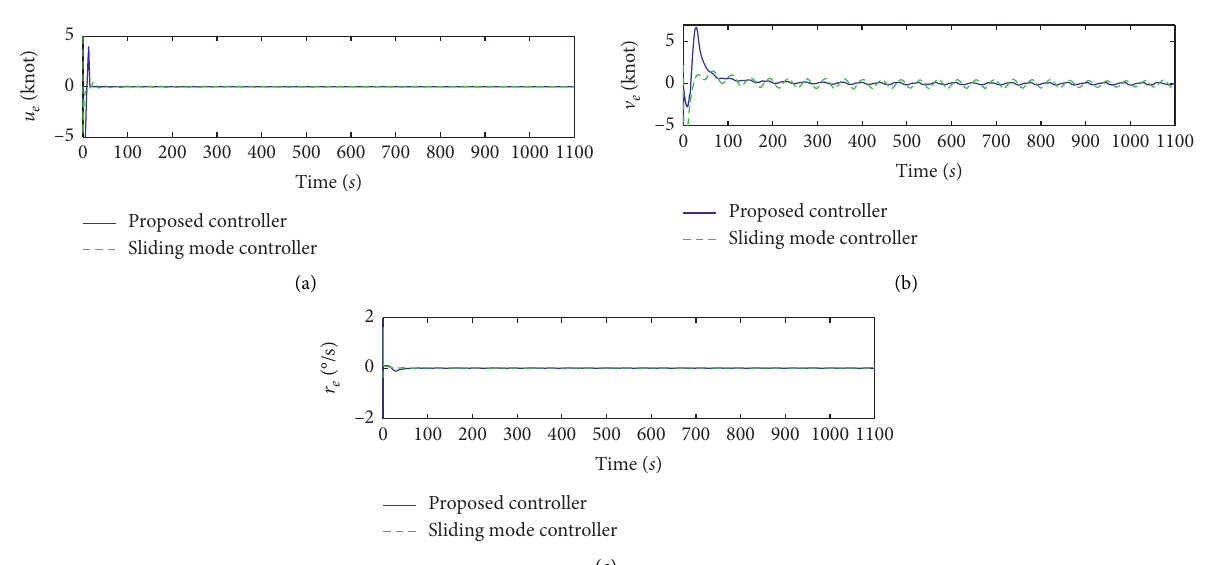
Figure 4: Input of two methods.